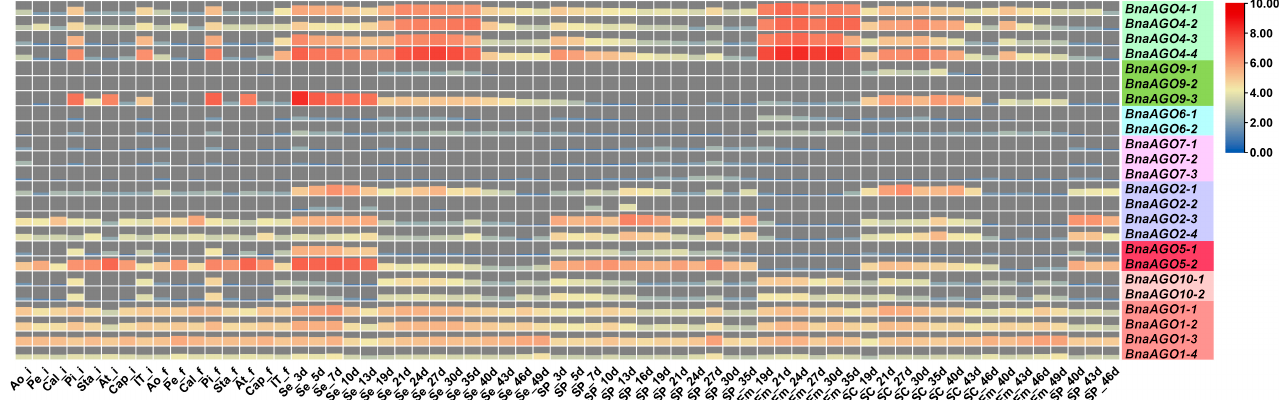
Figure 4. The expression level of the 24 identified BnaAGOs in ZS11 with 64 different tissues. The figure of 3d, 5d, 7d, 10d, 13d, 19d, 21d, 24d, 27d, 30d, 35d, 40d, 43d, 46d and 49d on the